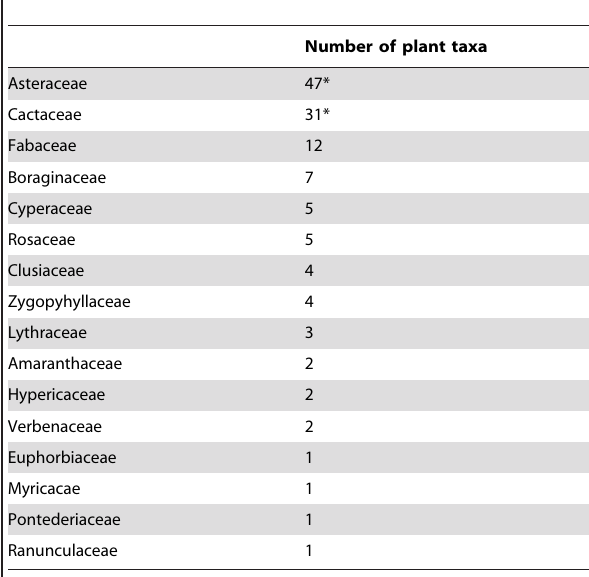
Table 4. Plant taxa with any non-target impact recorded from classical biological control agents of weeds, sorted by